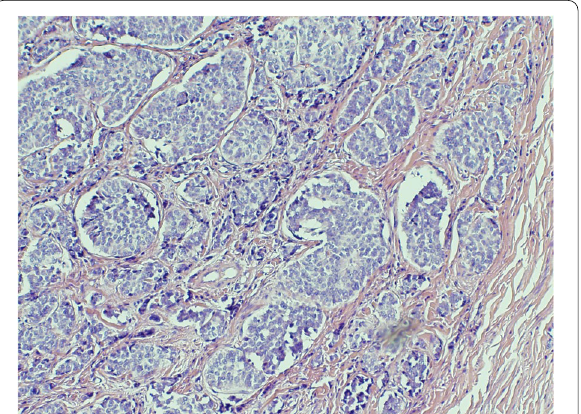
10): tumor cells are Fig. 4 Hematoxylin and eosin (H&E) stain (magnification: × tumor infiltration in clusters and layers that fills the appendix lumen, mild to moderate atypia in the nuclei, and salt‑pepper chromatin pattern in the